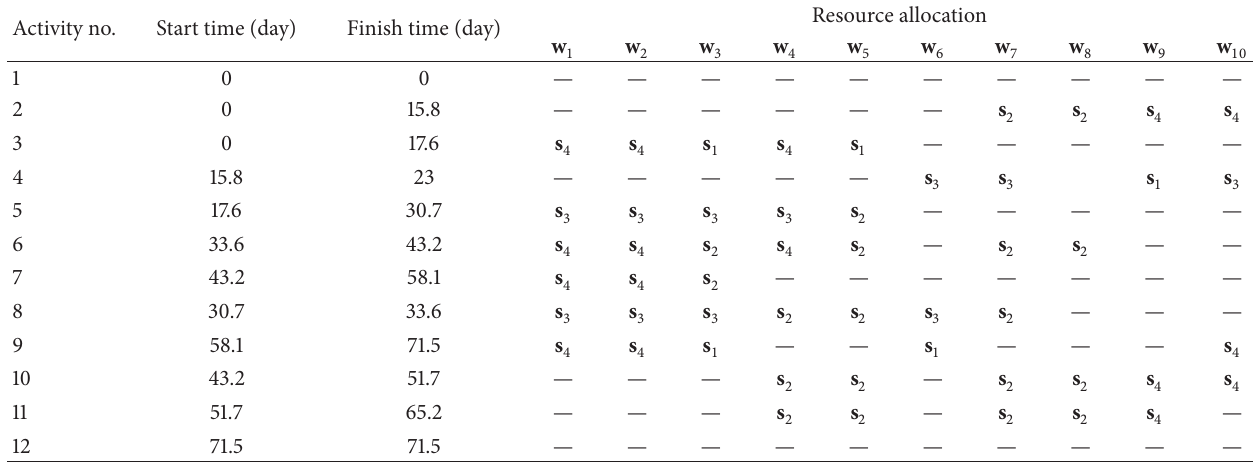
Table 4: Optimal schedule with top level of induced learning.